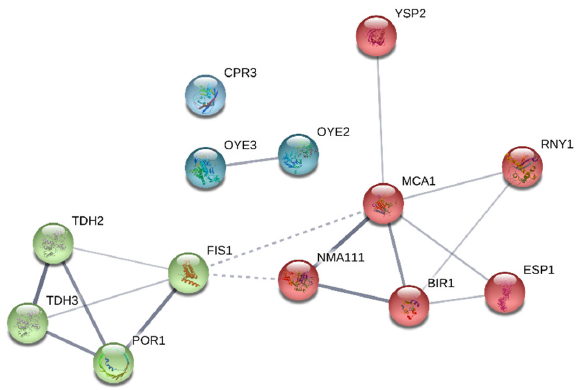
Figure 3. Interaction network map built using STRING v11.0 and based on the 13 apoptosis-related proteins in total detected in S. cerevisiae P29 and G1. Proteins are shown as nodes and the existence of interactions between them are represented by edges (connection between nodes). Edges thickness indicates the strength of the different interactions. Nodes with the same color represent specific clusters. PPI enrichment p ‐ value < 6.21 × 10 − 10 .